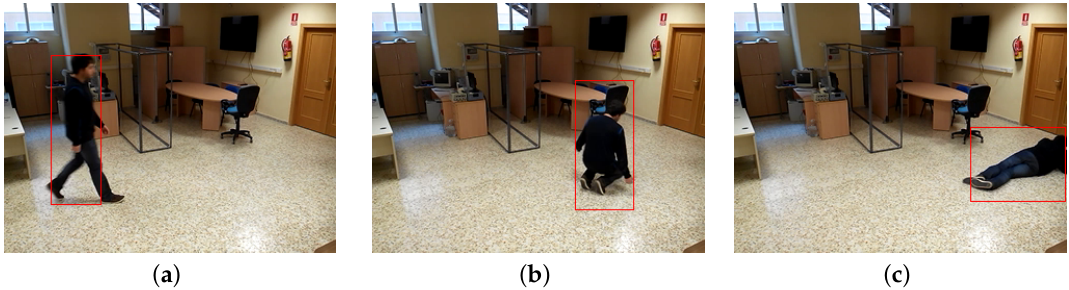
Figure 7. Kalman filter predictions for subject position. ( a ) Step 1: walking; ( b ) Step 2: fall initiated; ( c ) Step 3: fall